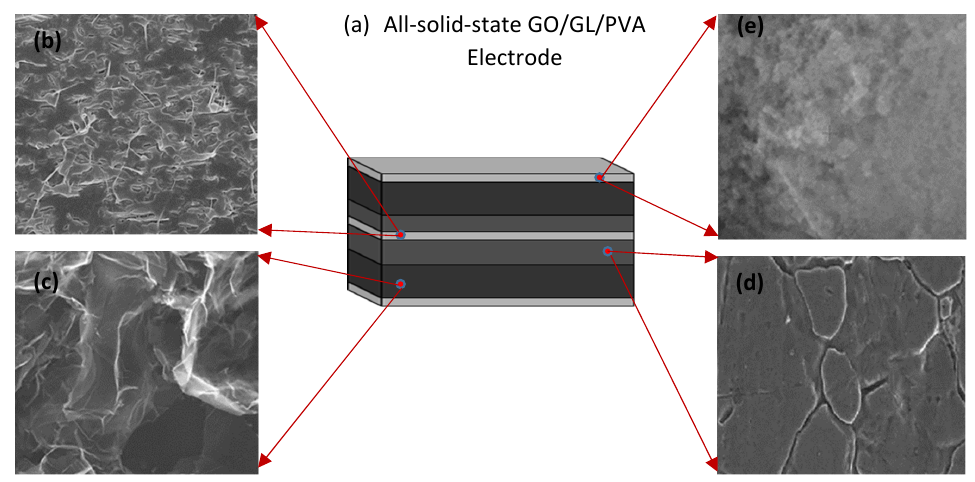
Figure 1. (a) General structure of solid-state GO/GL/PVA electrode, (b) Thickness with 4 µm separator (GO Figure 1. ( a ) General structure of solid-state GO/GL/PVA electrode, ( b ) Thickness with 4 µ m doped Ion Gel), (c) thickness with 500 nm carbon material doped with graphene, (d) thickness at 50 nm active separator (GO doped Ion Gel), ( c ) thickness with 500 nm carbon material doped with graphene, carbon derived from PVA, (e) thickness at 5 nm activated carbon coated on graphene sheets ( d ) thickness at 50 nm active carbon derived from PVA, ( e ) thickness at 5 nm activated carbon coated on graphene sheets.